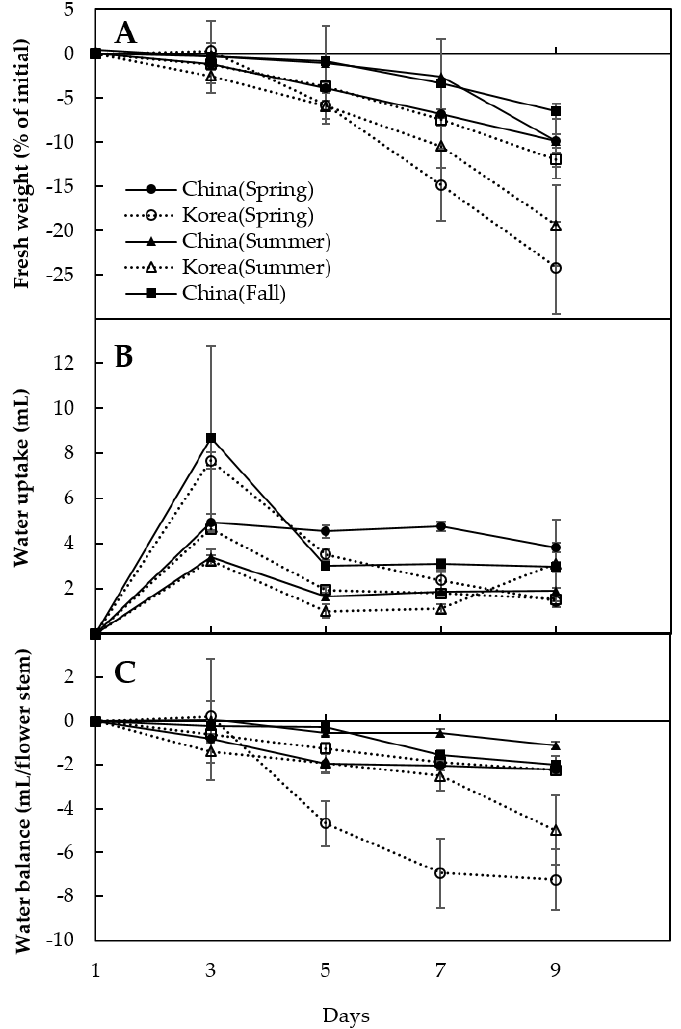
Figure 2. Changes of fresh weight ( A ), water uptake ( B ) and water balance ( C ) of cut Phalaenopsis “V3” flowers based on the place of origin and season. The ratio of dry and fresh weight of plants showed a higher value as the stress in- creased [21], and Korean flowers with a low moisture balance also showed a high ratio of dry and fresh weight in spring (Figure 3).